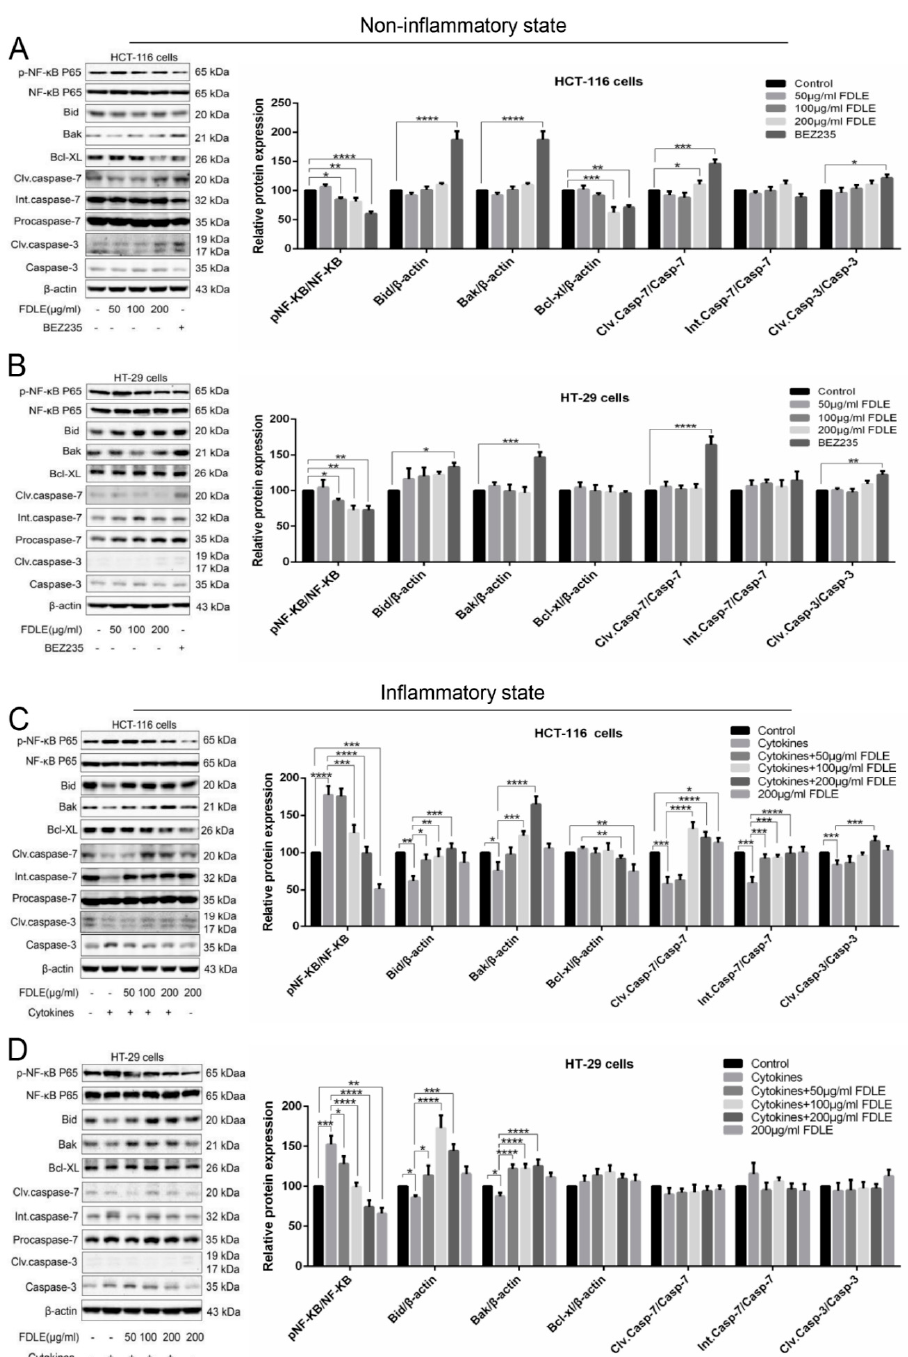
Figure 7. The effects of FDLE on NF- κ B-mediated expression of apoptotic proteins and activation of caspase enzymes in non-inflammatory and inflammatory HCT-116 and HT-29 colorectal cancer cell lines by Western blot. ( A , B ) The expression of apoptotic proteins and the activation of caspase enzymes in non-inflammation HCT-116 and HT-29 cells untreated and treated with three doses (50, 100 and 200 µ g/mL) of FDLE or BEZ235 for 48 h. ( C , D ) The expression of apoptotic proteins and the activation of caspase enzymes in inflammation HCT-116 and HT-29 cells untreated and treated with three doses (50, 100 and 200 µ g/mL) of FDLE for 48 h after adding cytokines (TNF- α , IFN- γ and LPS each 10 ng/mL) for 2 h. Densitometric quantification was performed by image software. The results were represented as mean ± SD of three independent experiments, * p < 0.05, ** p < 0.01, *** p < 0.001, **** p < 0.0001. The whole western blots are shown in File